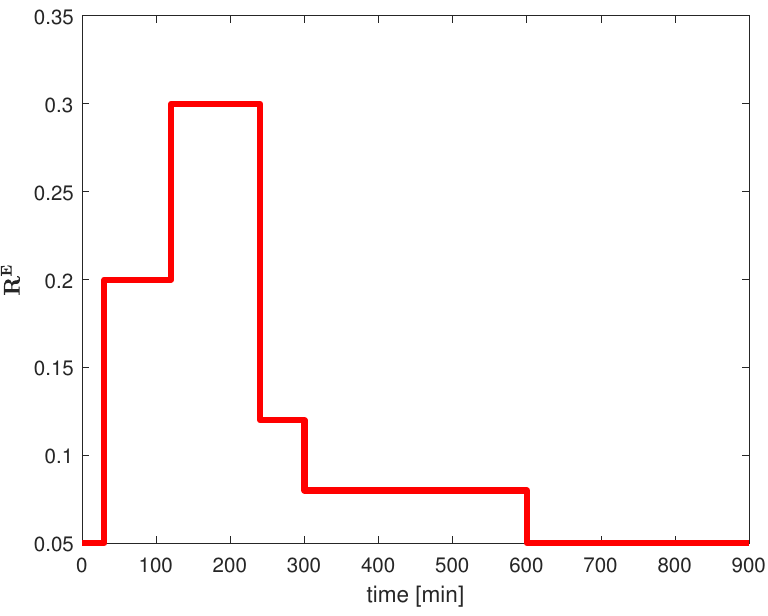
Figure 4. Scenario of an attack on the power